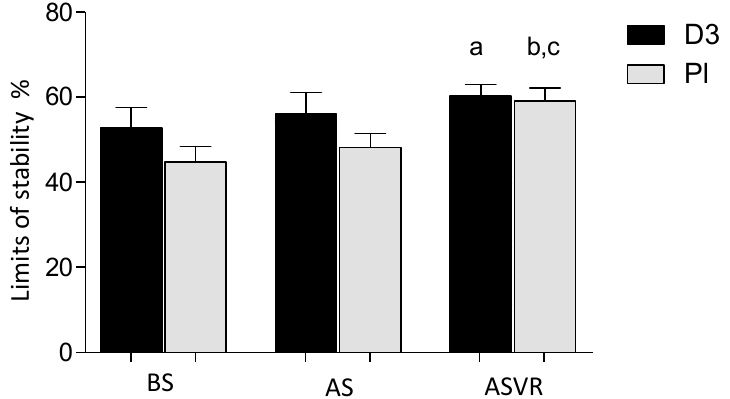
Figure 5. Vitamin D supplementation had no effects on the rehabilitation-induced improvement on the limits of stability of patients after anterior cervical interbody fusion surgery. Columns, mean and bars, standard deviations (SDs). a, p < 0.05, significantly different compared with the D3-BS; b, p < 0.05, significantly different compared with the Pl-BS; and c, p < 0.05, significantly different compared with and the Pl-after supplementation (AS) group, respectively by one-way ANOVA.